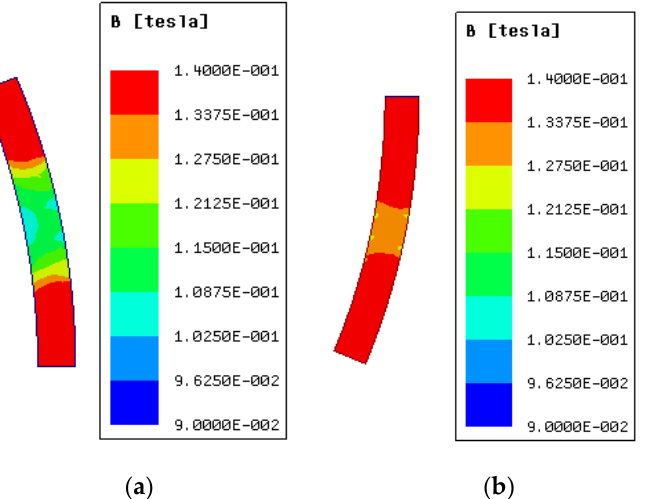
Figure 14. Demagnetization indicated by flux densities of NRE-FRG structure when the temperature variation: ( a ) at 20 (cid:2925) C , PF = 0.76; ( b ) at 120 (cid:2925) C , PF = 0.843.